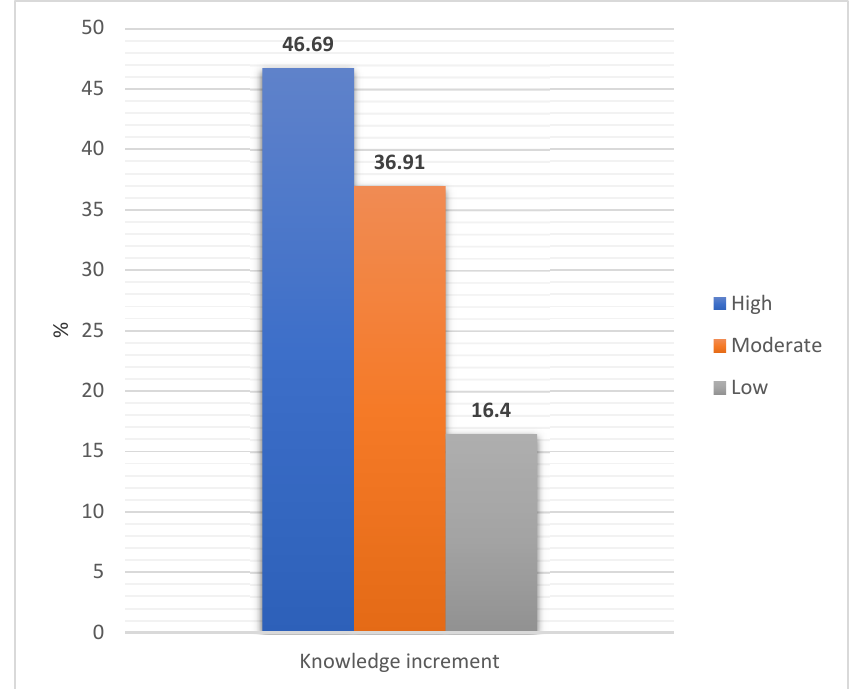
Figure 2. Increase in knowledge of surveyed students after the educational programme (chi-square test; p = 0.025, Cramer’s V = 0.15).